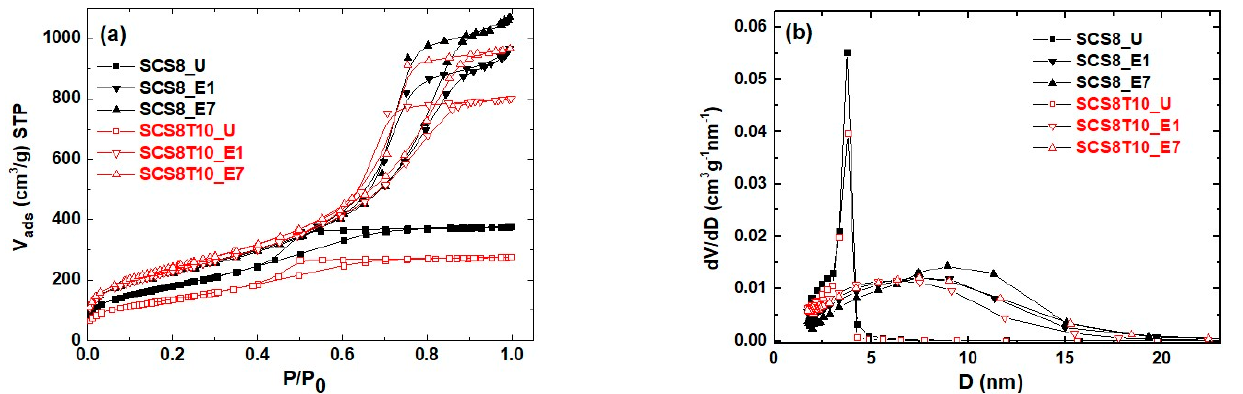
Figure 2. ( a ) N 2 isotherms and ( b ) pore size distribution of SCS8 and SCS8T10 xerogels subjected during sol-gel processing to different washing treatments (U, E1, and E7) before evaporative drying.